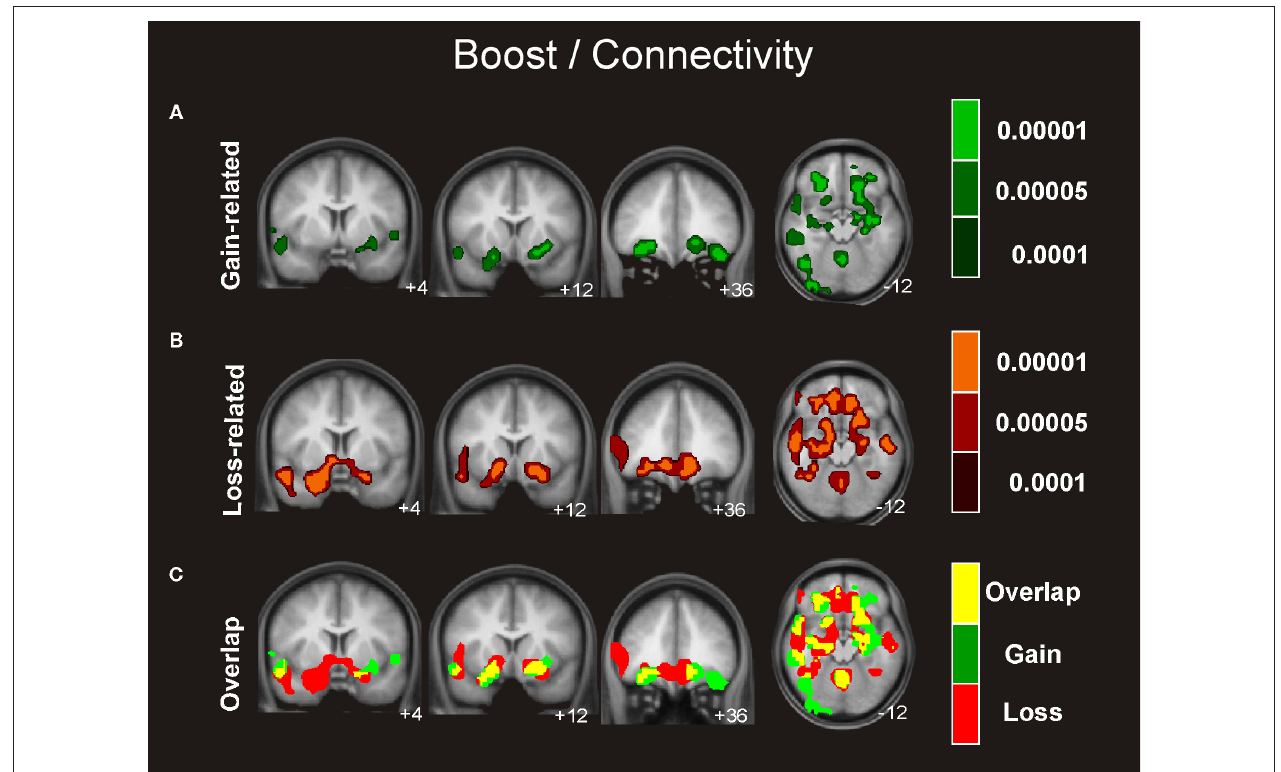
reward (A) , and punishment (B) condition using different statistical thresholds ( P < 0.0001; P < 0.0005; P < 0.001). Gains and losses connectivity patterns are simultaneously depicted in (C) : gain (green, P < 0.001), loss (red, P < 0.001), and conjunction gain (cid:2) loss (yellow, P < 0.001 and P <